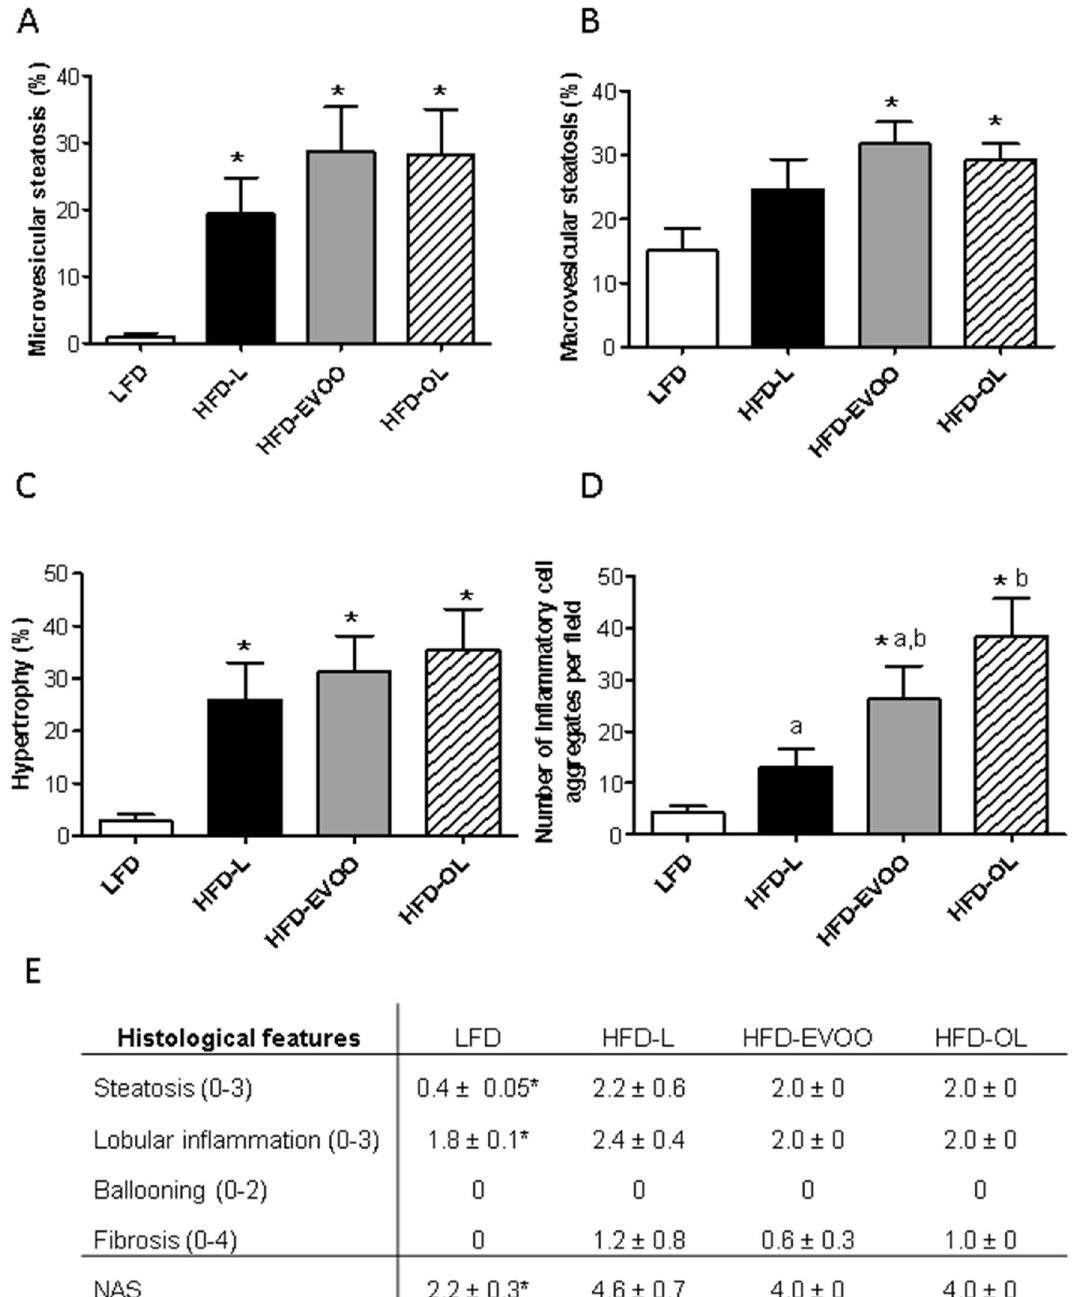
Figure 4. Diagnosis diagram for NAFLD after 32 weeks of nutritional intervention study. Values reported for steatosis based on the percentage of the total area affected: ( A ) Microvesicular, ( B ) Macrovesicular and ( C ) Hypertrophy. ( D ) Number of inflammatory foci per field at 100 × magnification. ( E ) Values reported for steatosis, lobular inflammation, hepatocyte balloon degeneration, fibrosis and NAS (total score) according to the NASH CRN Scoring system. Values represent the means ± SEM (n = 9). *p < 0.05 LFD vs HFDs groups; different letters denote significant differences between HFD groups ( p <